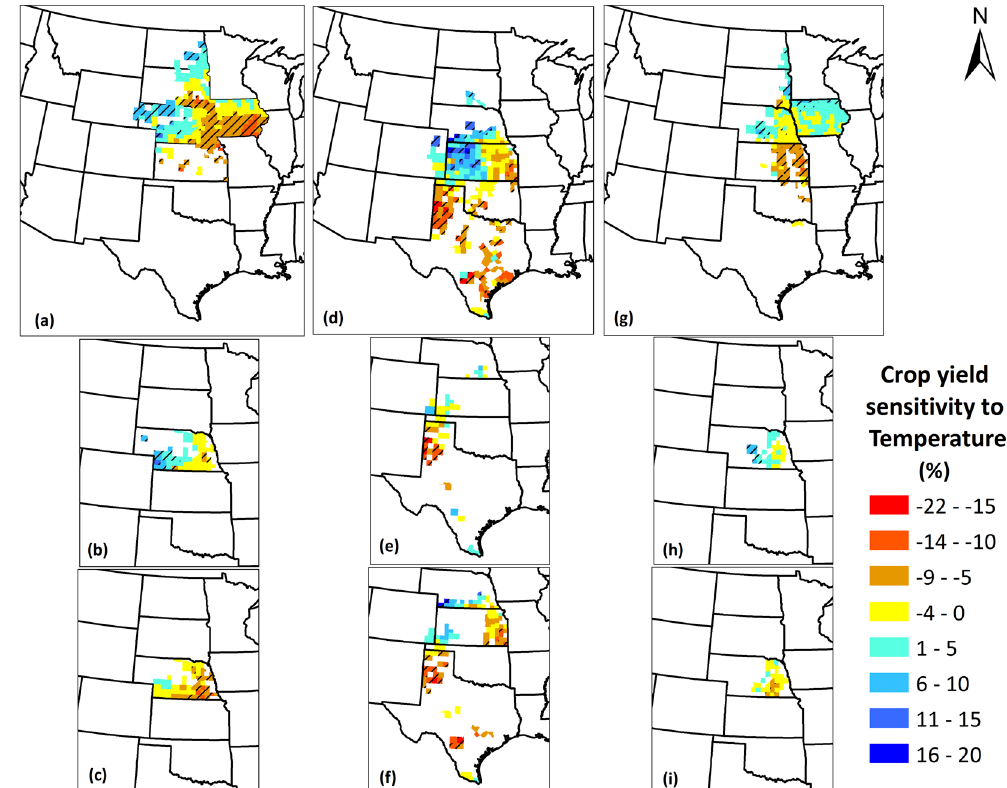
Figure 8. Crop yield sensitivity to temperature for ( a ) Maize; ( b ) Irrigated maize; ( c ) Non-irrigated maize; ( d ) Sorghum; ( e ) Irrigated sorghum; ( f ) Non-irrigated sorghum; ( g ) Soybean; ( h ) Irrigated soybean; ( i ) Non- irrigated soybean yields in the Great Plains counties over the period 1968–2013. The value represents change in crop yields as percentage of mean crop yields over 1968–2013 per 1 °C increase in temperature. Negative values indicate that the crop yields decrease with temperature rise and positive values indicate that they increase with temperature rise. Counties with striped lines indicate that the sensitivity magnitudes were statistically significant at 90% confidence level. We created the maps using ESRI ArcMap 10.4.1 software http://desktop.